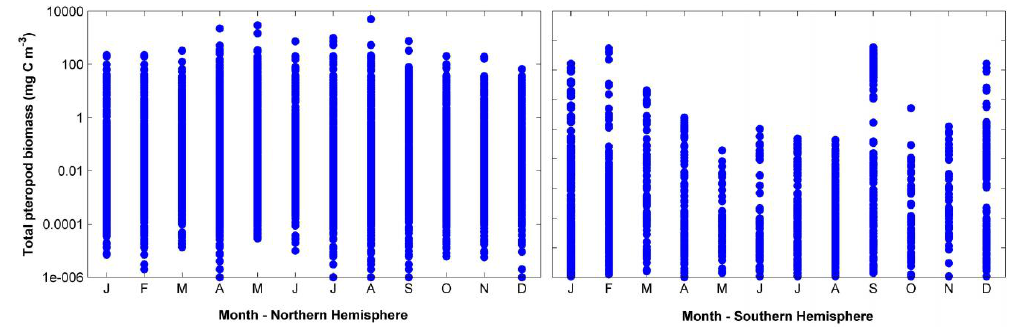
Figure 9. Distribution of pteropod biomass values (mgCm − 3 ) with respect to month, in the Northern Hemisphere (left) and Southern Hemisphere (right). Figure 9: Distribution of pteropod biomass values (mg C m -3 ) with respect to month, in the Northern Hemisphere (left) and Southern1002 Hemisphere (right).1003 Table 7. Biomass (mgCm − 3 ) with respect to season for the Northern (NH) and Southern (SH) Hemispheres, showing the calculated mean, standard deviation (SD), median, minimum (min) and maximum (max). Biomass statistics are based on non-zero data entries